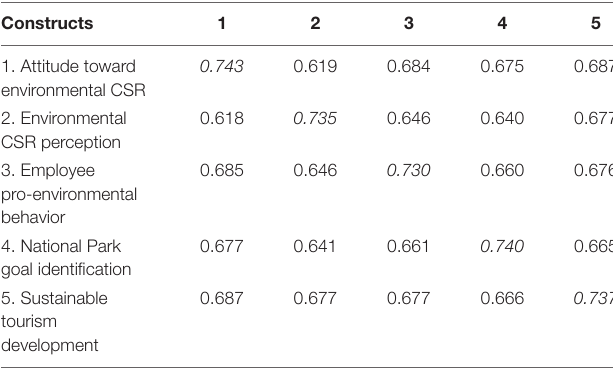
TABLE 3 | Discriminant validity analysis (Fornell-Larcker and HTMT).